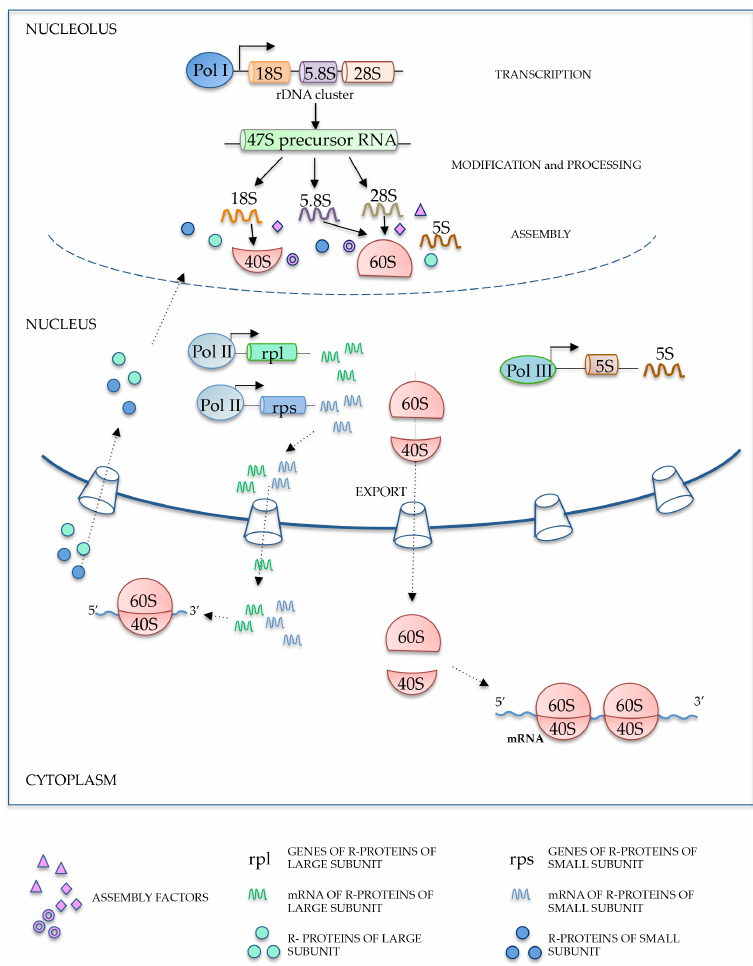
Figure 1. Schematic representation of ribosome biogenesis. rDNA: ribosomal DNA; Pol I: polymerase I; Pol II: polymerase